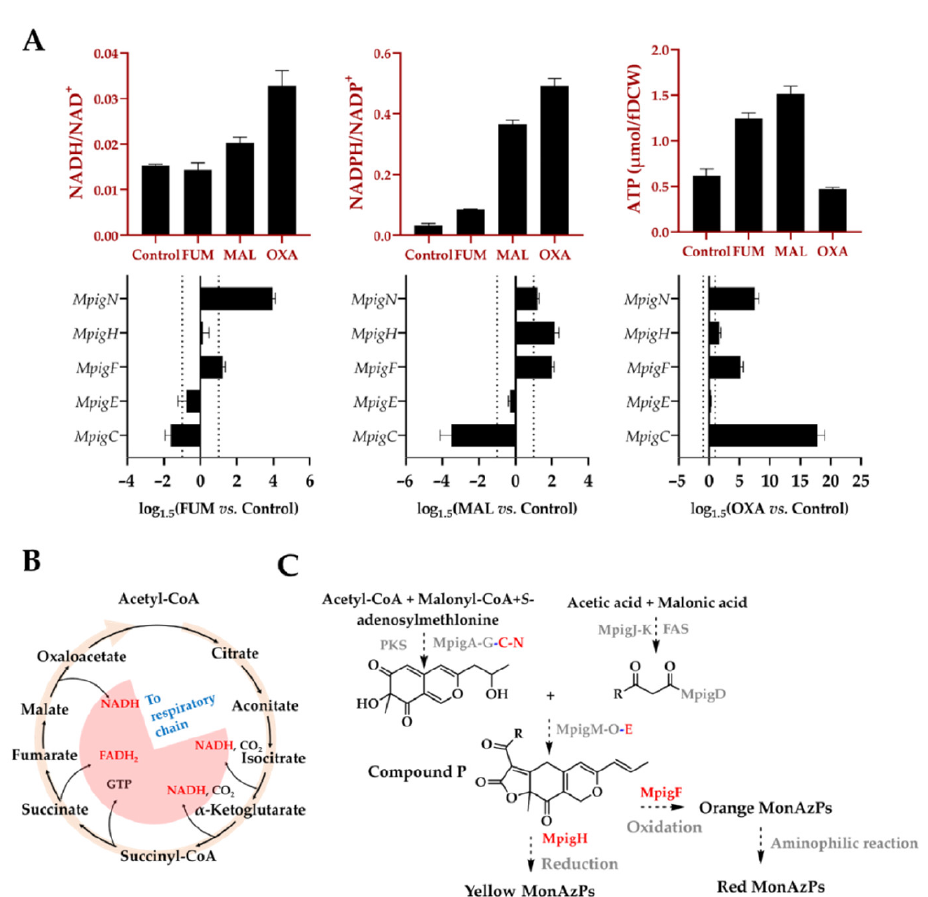
Figure 6. ( A ) Changes of ATP, reductive equivalents (NADH, NADPH), and the expressions of dehydrogenase genes involving with MonAzPs biosynthesis after supplementing fumarate, malate, and oxoacetate, respectively; ( B ) TCA cycle; and ( C ) MonAzPs synthetic pathway. MpigA, nonre- ducing polyketone synthase; MpigB, transcription factor; MpigC, C-11-ketoreductase; MpigD, 4-O-Acyltransferase; MpigE, NAD(P)H-dependent oxidoreductase; MpigF, oxidoreductase; MpigG, serine hydrolase; MpigH, enoyl reductase; MpigJ, FAS subunit α ; MpigK, FAS subunit β ; MpigM, O- acetyltransferase; MpigN, monooxygenase; MpigO, deacetylase; MpigI, transcription factor; MpigL, ankyrin repeat protein; MpigP, major facilitator superfamily multidrug